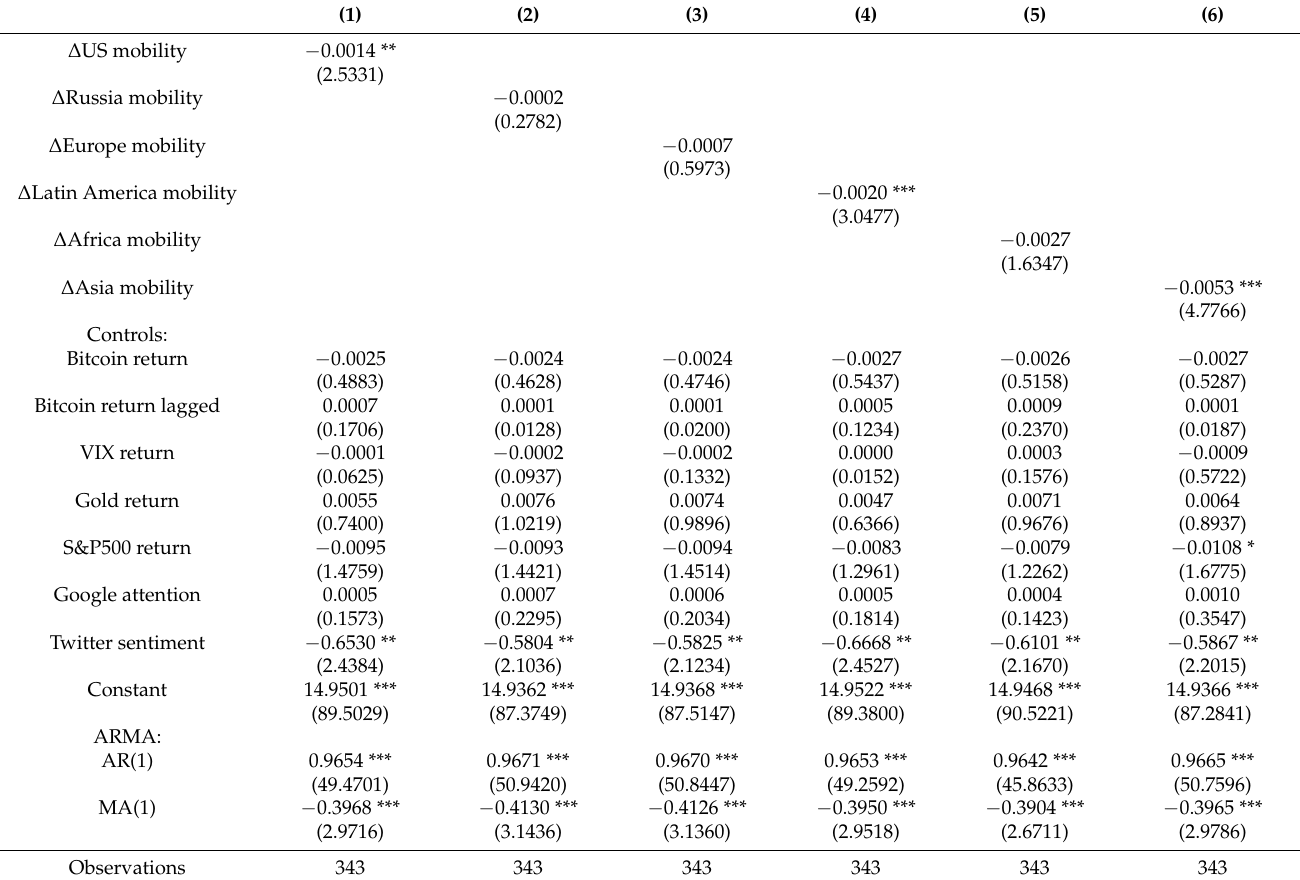
Table 4. The impact of mobility on Bitcoin trading volume, by country and